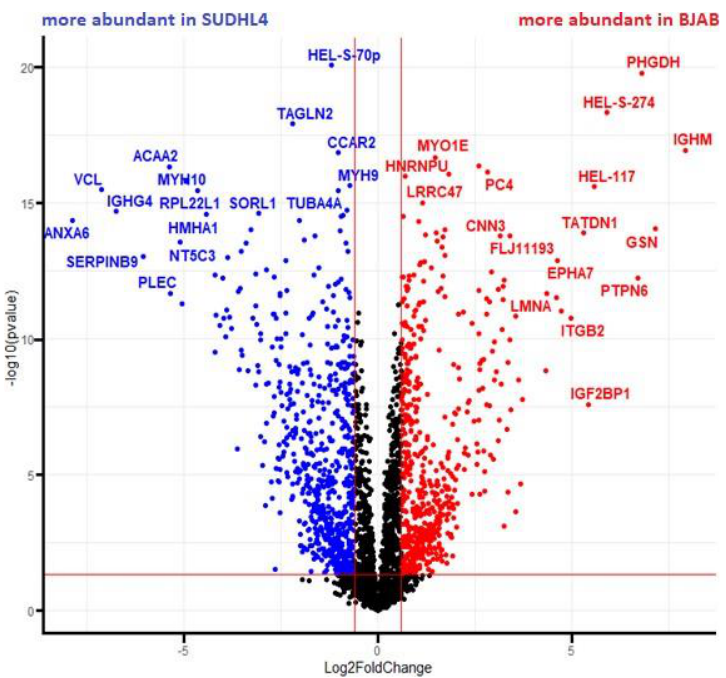
Figure 4. Volcano plot analysis of log2 normalized protein intensity values for BJAB/SUDHL4 cells. Non-paired t-test with false discovery rate (FDR) correction (0.05) was implemented. Each colored dot represents a protein fulfilling the significance criteria (|log2 FC| > 0.6; p -value < 0.05). For selected significant hits gene names are displayed.